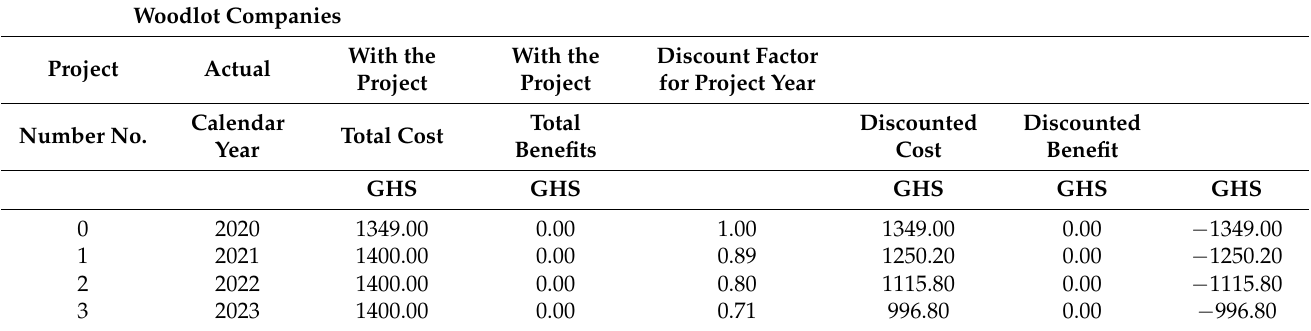
Table A9. Profitability of woodlot farmers (those who are in